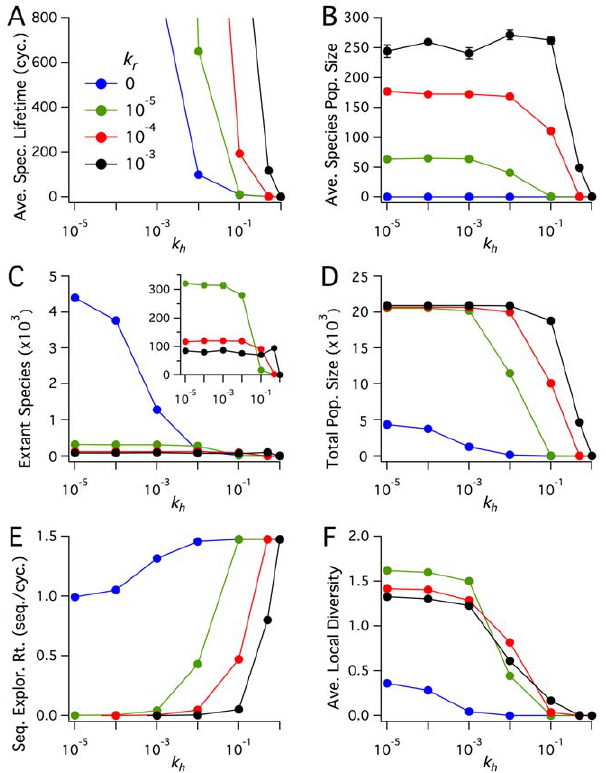
Figure 2. Exploring kinetic parameter space. Plots of quasi steady-state values of Average Species Lifetime (in units of number of cycles), Average Species Population, Extant Species, Total Population Size, Sequence Exploration Rate (in units of number of novel sequences generated per cycle), and Average Local Diversity. Time averages were taken from t ~ 2500 { 5000 cycles, and each point is the ensemble average over five realizations. Error bars denote the sample standard deviation (most are smaller than symbols). The rate constant for spontaneous sequence nucleation is k s ~ 10 { 7 , and the diffusion rate constants are k p ~ 0 : 01 sites/cycle and k m ~ 1 : 0 sites/cycle. The blue data set shows the reference case with k r ~ 0 , where no polymers